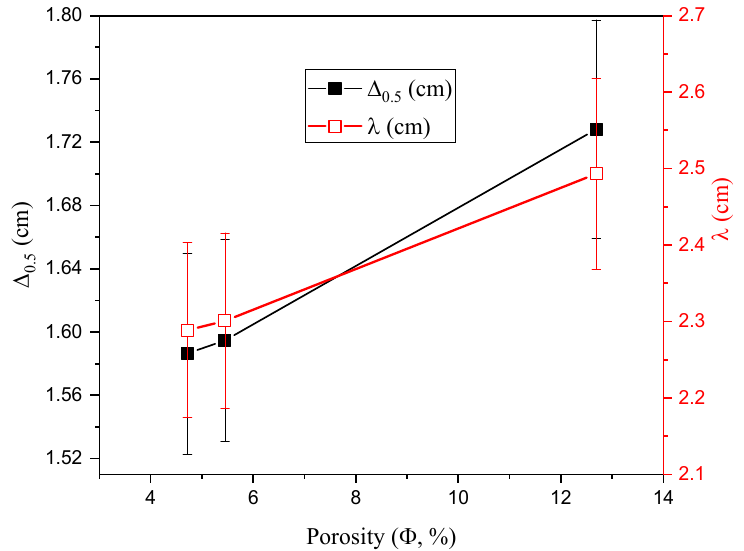
Figure 7. Influence of the porosity on both the half ‐ value thickness ( Δ 0.5 , cm) and mean ‐ free path ( λ , cm) at a fixed E γ of 661